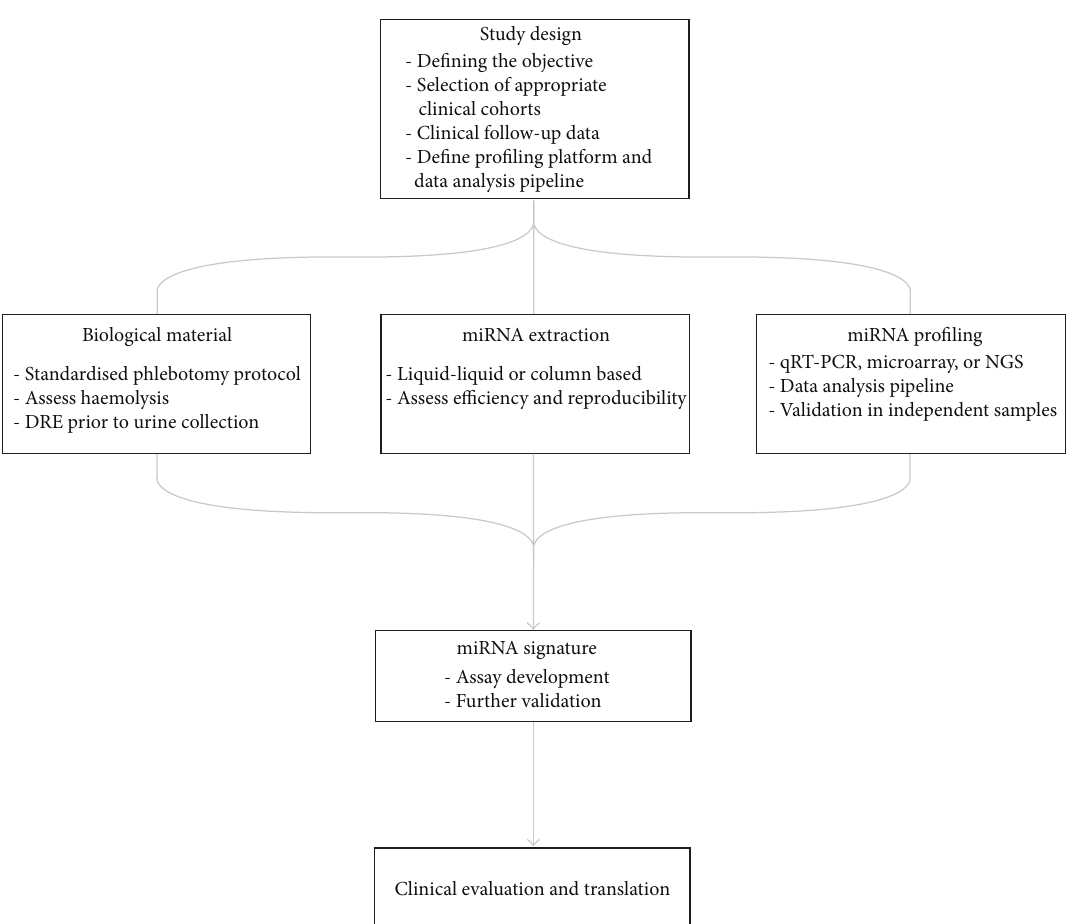
Figure 1: Pipeline for developing circulating and urine miRNAs as biomarkers of disease, with important considerations shown. Study design is critical and will influence all aspects of the methodology. Clinical evaluation and translation, including clinical trials, commercialisation, and approval, have been discussed elsewhere (e.g., see [13]) and are not included in this paper.